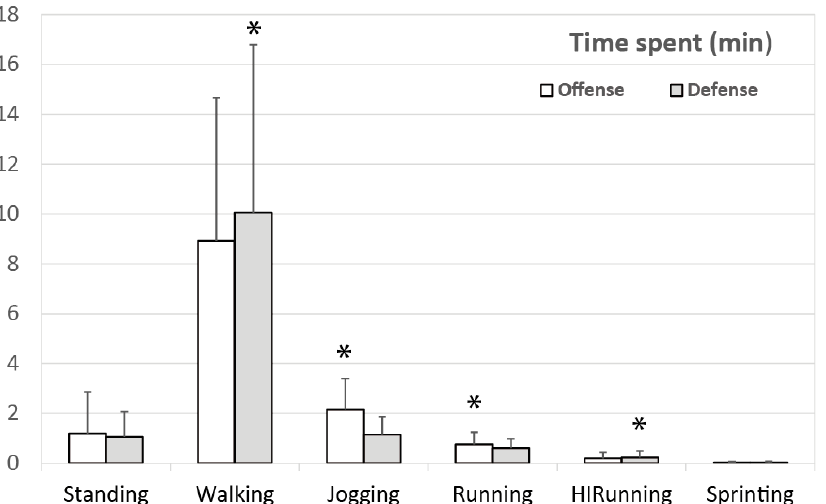
Figure 2. Time spent in court in each locomotion category by offense and defense. * Significant differences between offense and defense ( p < 0.05).